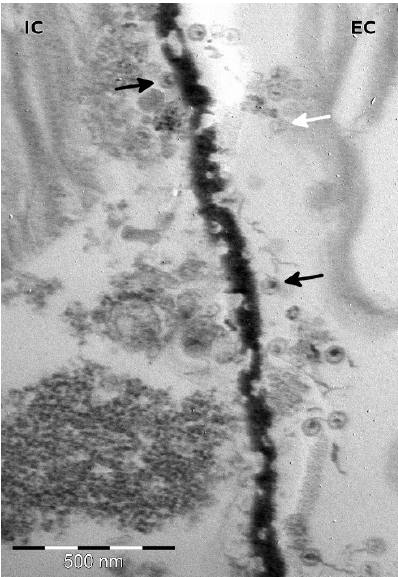
Figure 2. Thin section of a T. striata showing TsV-N1 particles inside (IC) and outside (EC) the cell. Black arrow: filled viral particle, white arrow: empty capsid. Note the hexagonal section of the virions.